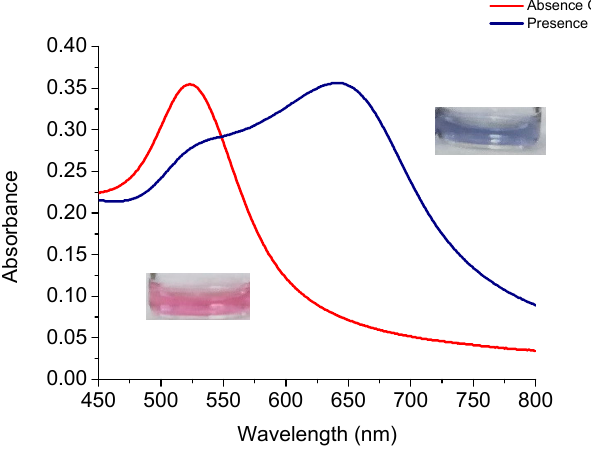
Figure 2. GNP1 UV–Vis spectra variation in absence and presence of 100 mM of GHB, using deionized water as solvent.